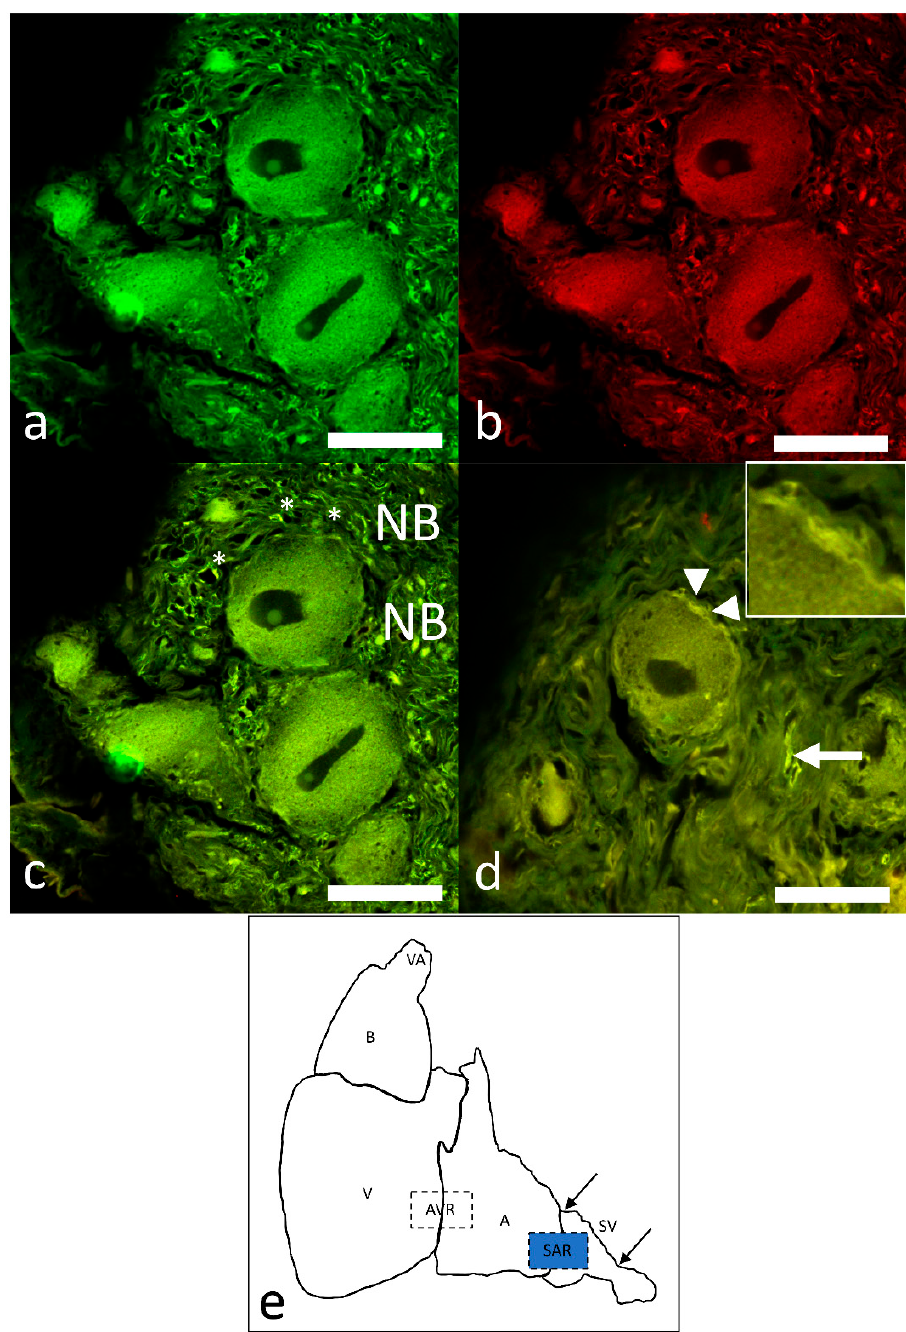
Figure 4. ( a – c ). Confocal images of intracardiac neurons immunostained with antibodies against ChAT and nNOS in the SAR. ( a ) (ChAT, green), ( b ) (nNOS, red) and ( c ) (merge) showing a complete overlapping of ChAT- and nNOS-positive neurons. Note the nerve fibers forming thick bundles (NB) are present in close vicinity of the presumptive pacemaker tissue, which is indicated by asterisks. ( d ) ChAT–nNOS neural terminals that surround the neuron and contain varicosities (arrowheads and inset). ( e ) Schematic indicates the cardiac regions: VA, ventral aorta; BA, bulbus arteriosus; V, ventricle; AVR, atrioventricular region; A, atrium; SAR, sinoatrial region; SV, sinus venosus. The blue highlighted area indicates the region of tissue sampling. Scale bars: 20 µm.